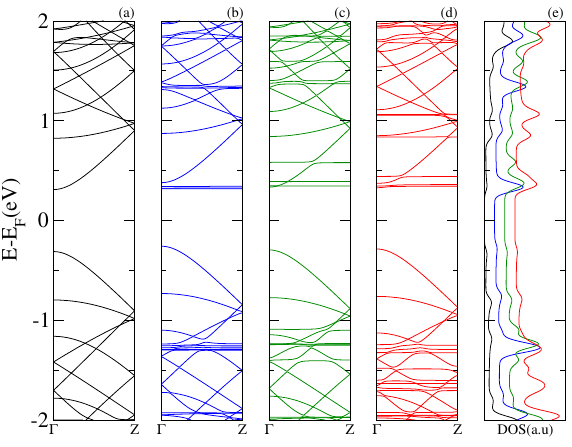
Figure 3. Electronic band structure of the 8GR–fullerene system for a wave vector along the z direction. Each panel displays the energy bands for the pristine 8GR in ( a ), and for the different hybrid systems: 8GR–C 60 in ( b ), 8GR–PCMB in ( c ), and 8GR–C 70 in ( d ). Panel ( e ) shows the total DOS.